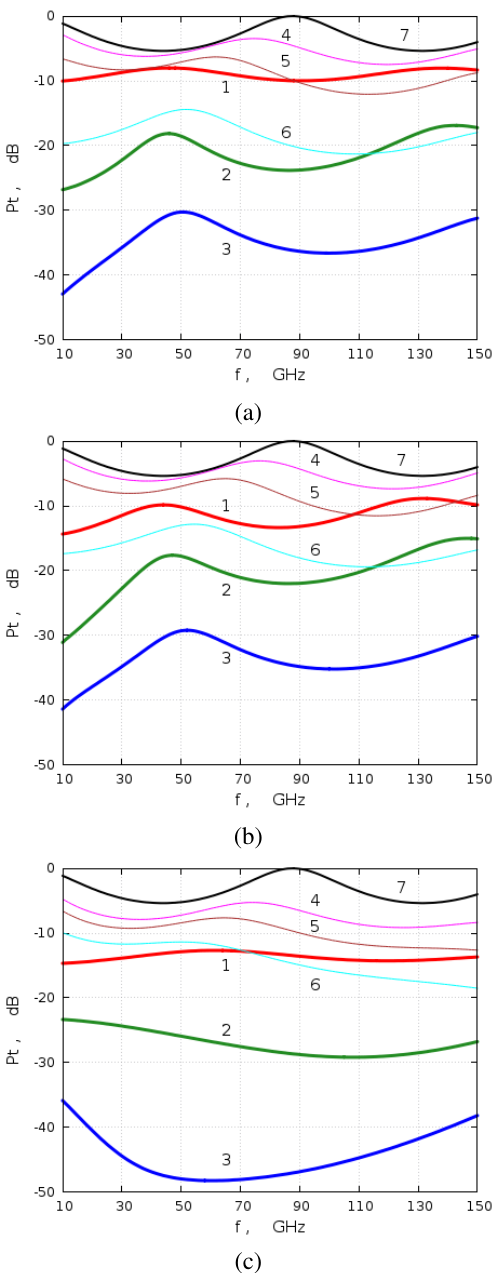
Figure 3: Reflection from (a) strip-like, (b) wire-like, and (c) fin-like photo-excited gratings for MM waves of E (curves 1 to 3) and H (curves 4 to 6) polarization at (a) P L = 0 . 1 , 1 , 10 kW/cm 2 , (b) P L = 1 , 10 , 100 kW/cm 2 , and (c) P L = 0 . 1 , 0 . 3 , 1 kW/cm 2 , respectively (curve 7 shows the dark-state